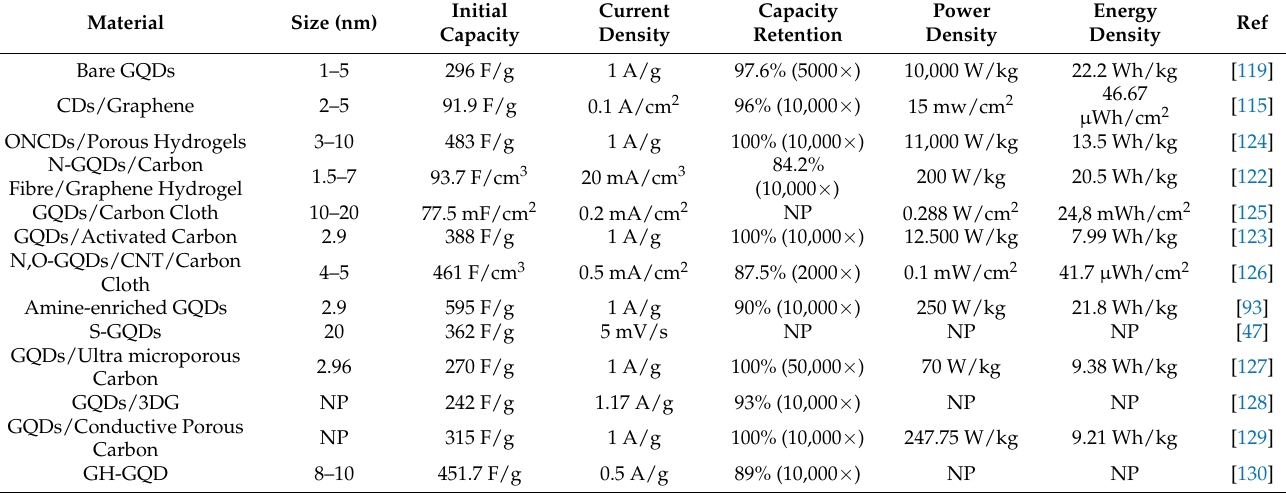
Table 1. Summary of various bare C-QD electrodes or combination with other carbon-based materials. NP = Not Published.